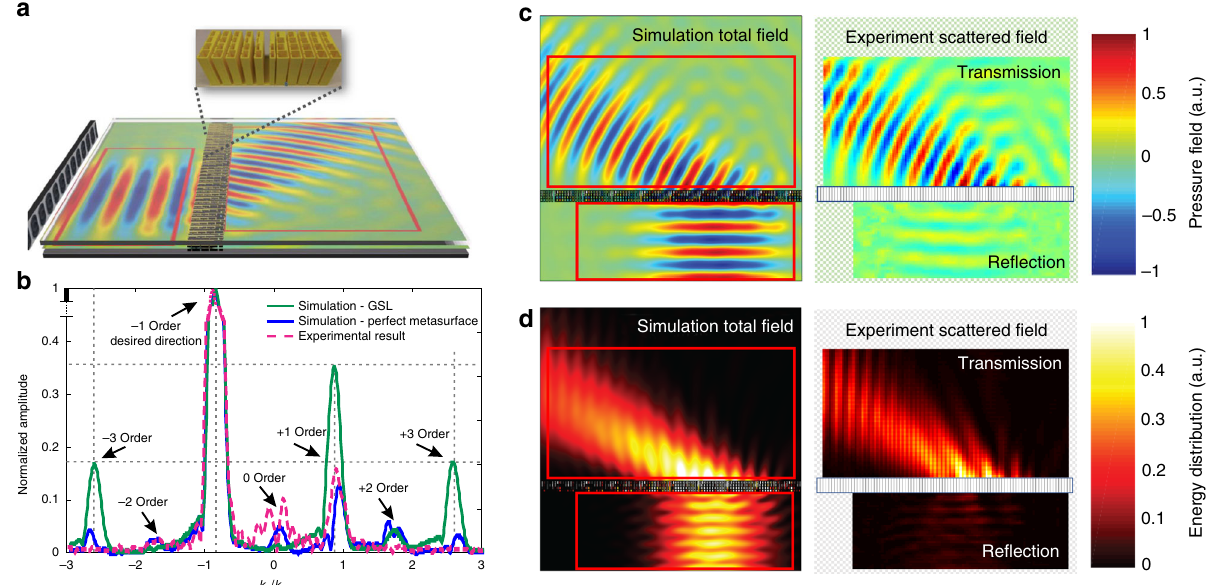
Fig. 5 Experimental setup and results. a Schematic representation of the experimental setup and a period of the fabricated sample. b Comparison between the normalized scattering of the bianisotropic metasurface (experimental and numerical) and a GSL design. Analysis of the real part c and magnitude square d of the experimental pressure fi eld and the comparison with the numerical